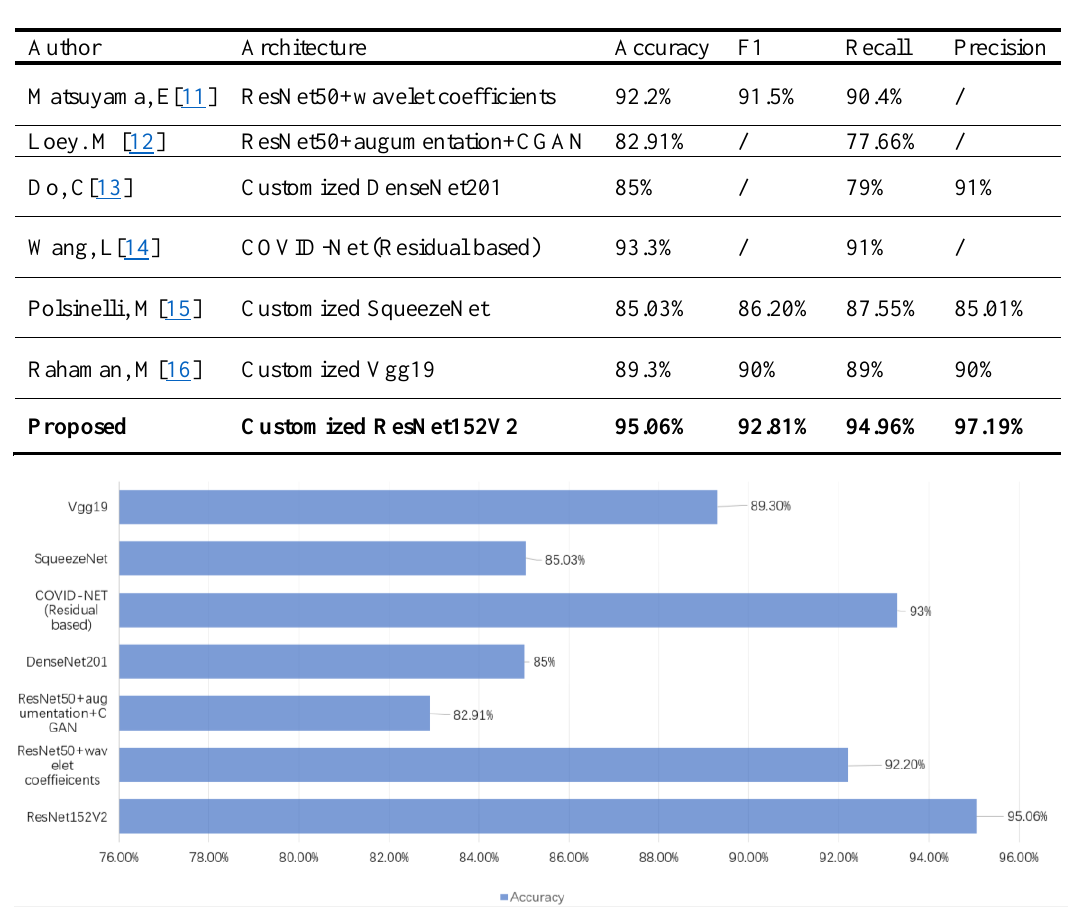
Table 3. Comparison with state of the art approaches